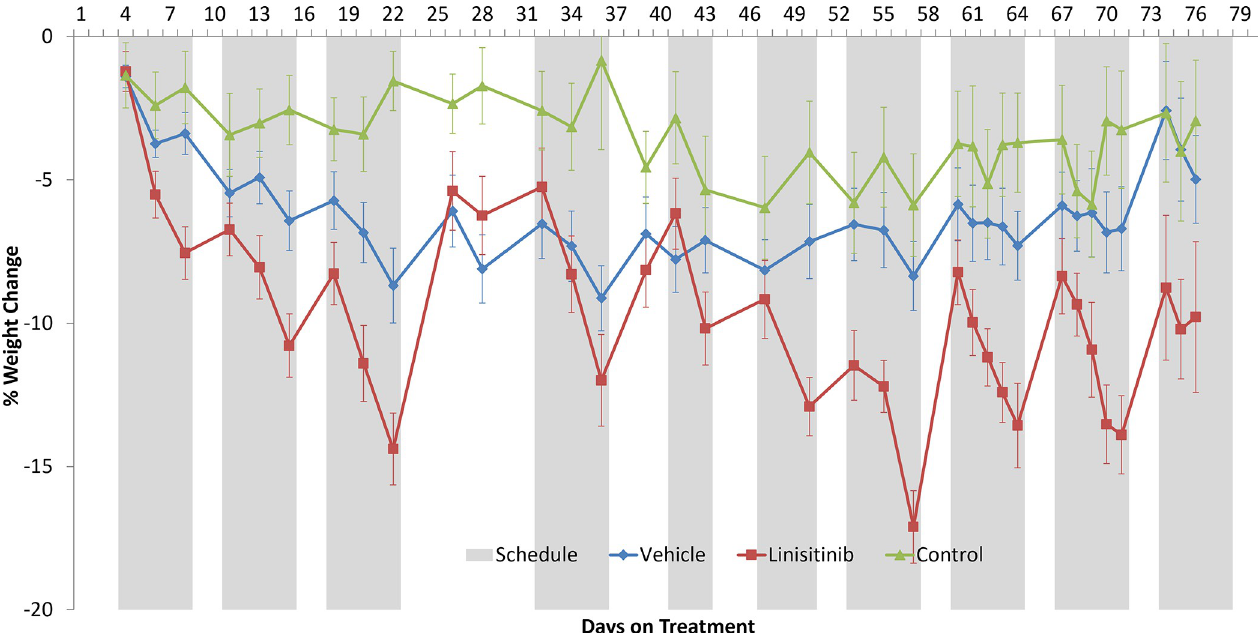
Fig 5. Effect of linsitinib, vehicle and untreated control on animal body weight on SCID mice implanted with HCC1143 cells. The treatment schedule is represented by the grey bars whereby white bars indicate days the animals did not receive treatment. Body weights were measured three times per week. Percentage weight change was monitored relative to the body weight at the time of implant. The mean percentage weight change and standard error of each group are shown. Statistically significant differences were calculated by two-way ANOVA using GraphPad Prism v8 and is represented by � or �� where � = < 0.05, �� <